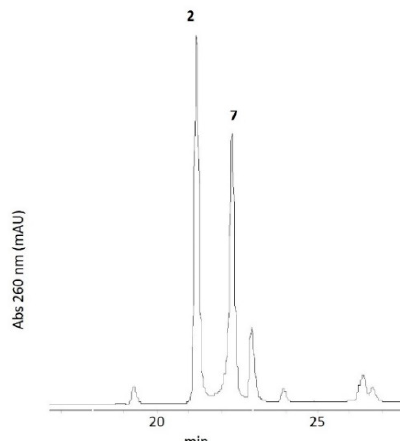
Figure 11. HPLC trace of isolated 2 (Rt = 21 min) showing one major degradation product (7) and a minor one, at Rt 22 and 22.5 min, respectively.